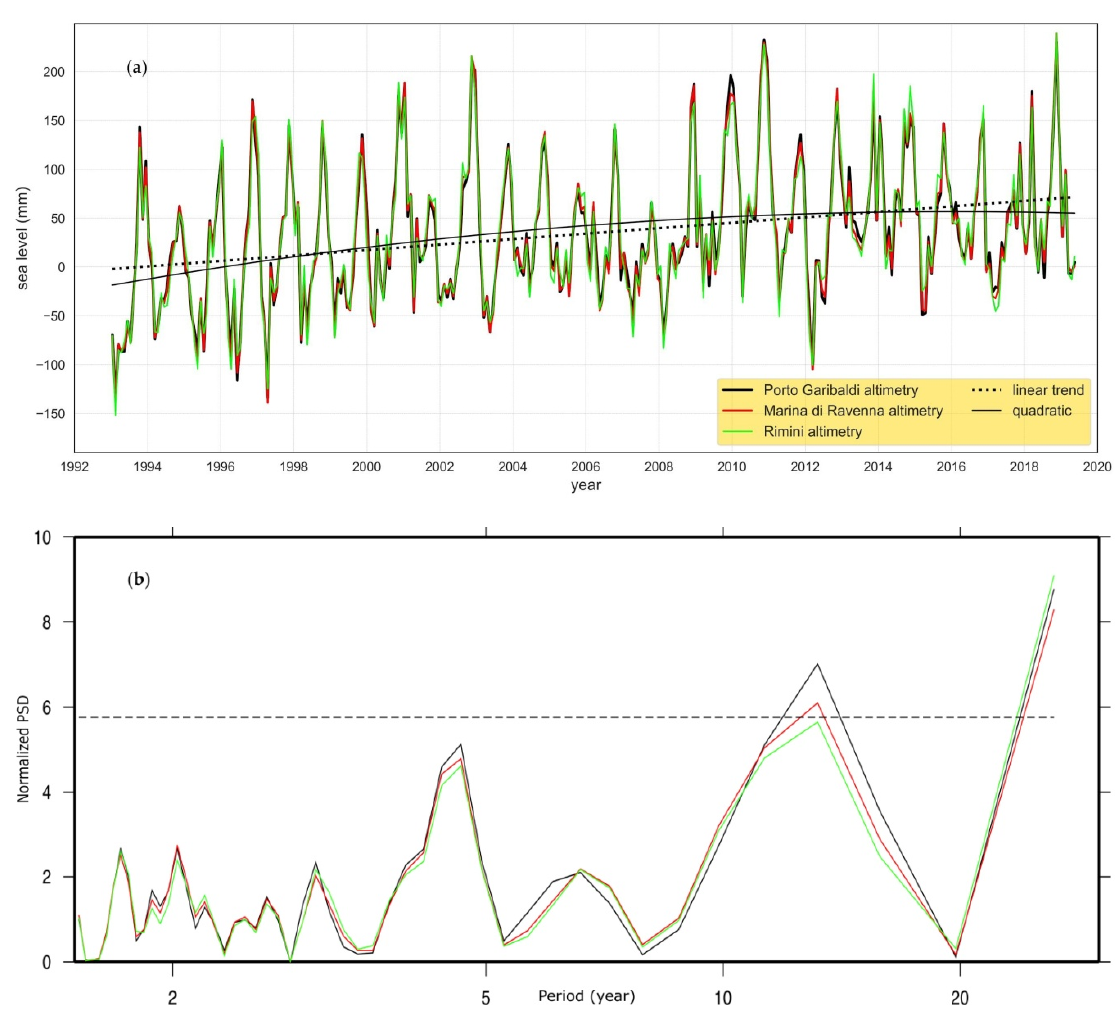
Figure 2. ( a ) SA PG , SA RA , SA RN time series with superimposed linear and quadratic model for the sole case of SA PG . ( b ) Lomb–Scargle periodograms for the three time series. Color coding is black for SA PG , red for SA RA , and green for SA RN . Measure unit is normalized power spectral density (PSD). At small periods, the periodograms are limited to 1.5 years to enhance the readability at long periods. The dashed line represents the significance (90%) of the periodogram. Table 1. Linear trend rate and acceleration estimated in this work from SA data. Symbol *** indicates that the model is strongly significant with p < 0.001 and symbol * refers to p <